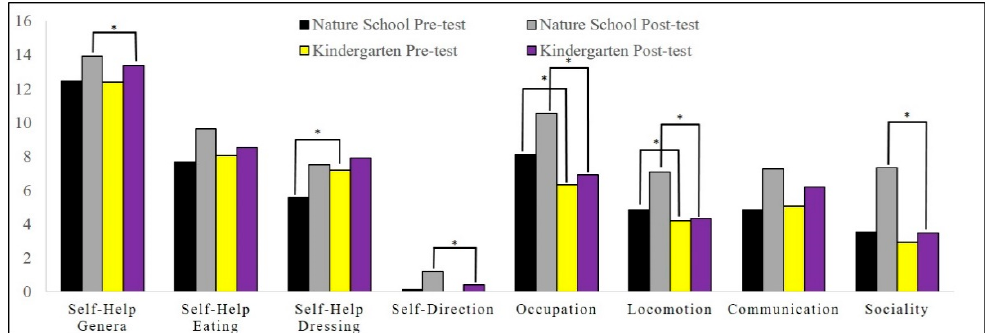
Figure 3. Descriptive statistics of the social development subscales. * p ≤ 0.05.